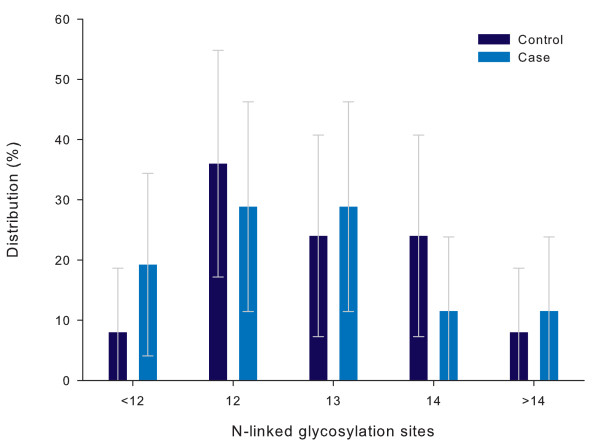
Distribution of potential N-linked glycosylation sites on V1-V2-V3 per study group. Distribution of number of potential N-linked glycosylation sites on the V1-V2-V3 fragment in children with severe anaemia (cases, Hb<5.0 g/dL) as compared to those without severe anaemia (controls). The distribution is expressed as a percentage of the total number of fragments analysed per study group (Controls: n = 25, Cases n = 26). Error bars express 95%. p = 0.75.